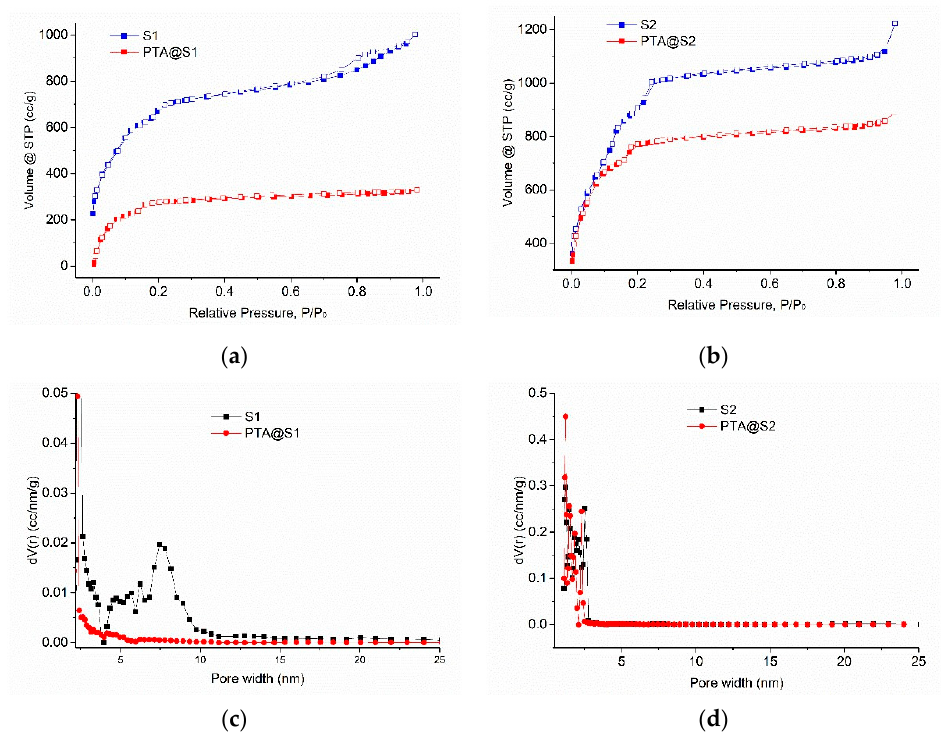
Figure 3. N 2 adsorption-desorption isotherms of ( a ) S1, PTA@S1, ( b ) S2 and PTA@S2. Pore size